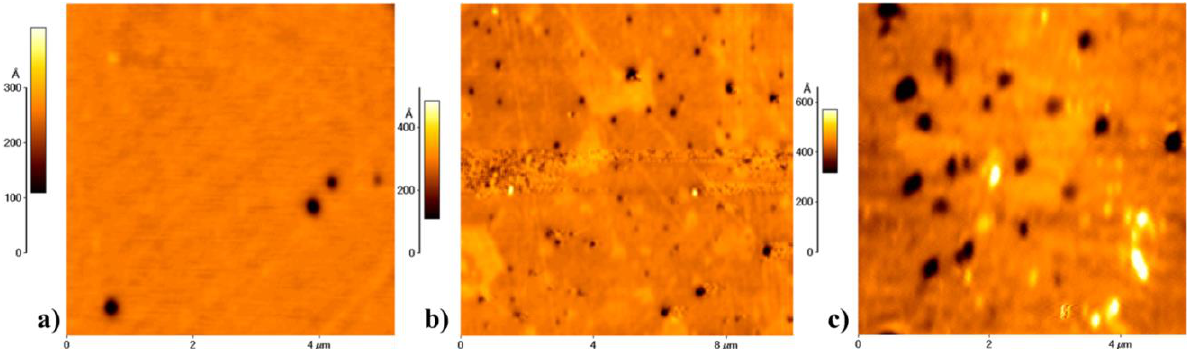
Figure 1. Atomic Force Microscope AFM pictures of the membrane obtained by the acid etching of nano iron particles at different times (pore size): ( a ) before etching (20 – 50 nm); ( b ) after 1 h of etching (20 – 100 nm); ( c ) after 6 h of etching (80 – 100 nm).